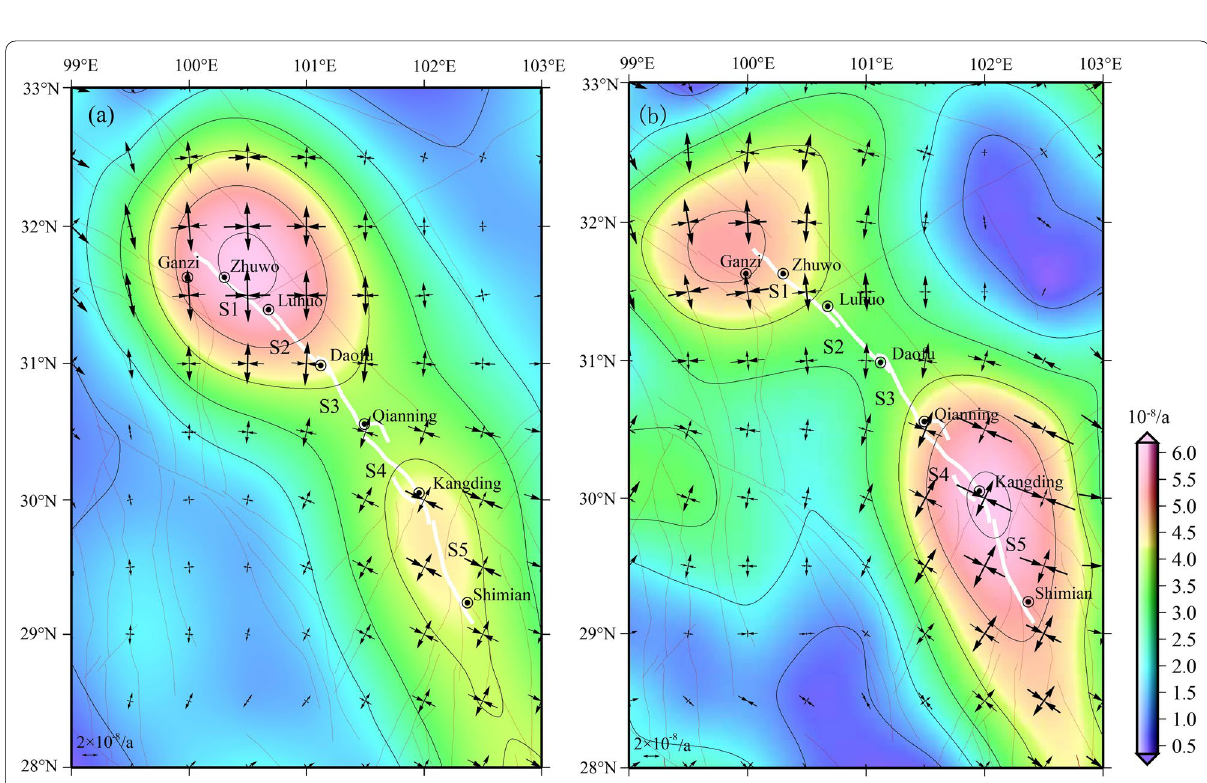
Fig. 5 Principal and maximum shear strain rate fields around the Xianshuihe Fault Zone. a and b The results during 1999–2007 and 2016–2020. The black arrows represent the principal strain rates; and the background contours represent the maximum shear strain